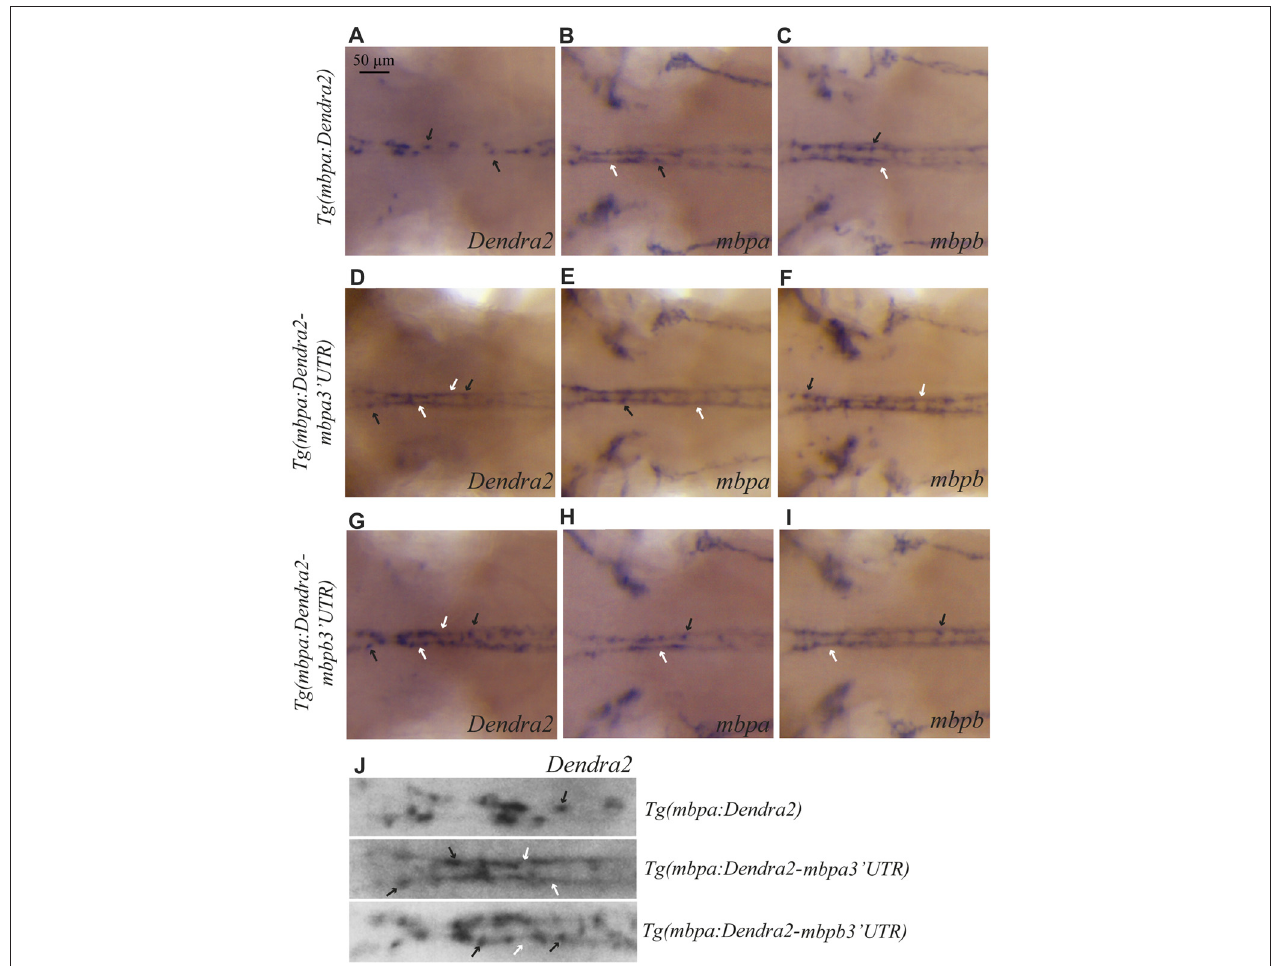
FIGURE 6 | The 3’UTRs from mbpa and mbpb affect the cellular localization of mRNA. WISH on transgenic larvae with probes specific for Dendra2 (A,D,G) , mbpa (B,E,H) , or mbpb mRNA (C,F,I) , as indicated. All pictures represent dorsal views of the neck region. mRNAs localized in cell bodies are indicated by black arrows, and localization in myelin sheaths is marked by white arrows. In the Tg(mbpa:Dendra2) larvae, Dendra2 mRNA is exclusively localized in cell bodies (A) . This localization is markedly different from the localization of Dendra2 mRNA when the 3’UTR from either mbpa or mbpb is present (D,G) . The localization of endogenous mbpa (B,E,H) and mbpb (C,F,I) mRNAs is similar in all three transgenic strains. (J) Enlarged view of the neck region of Dendra2 WISH of (A,D,G)